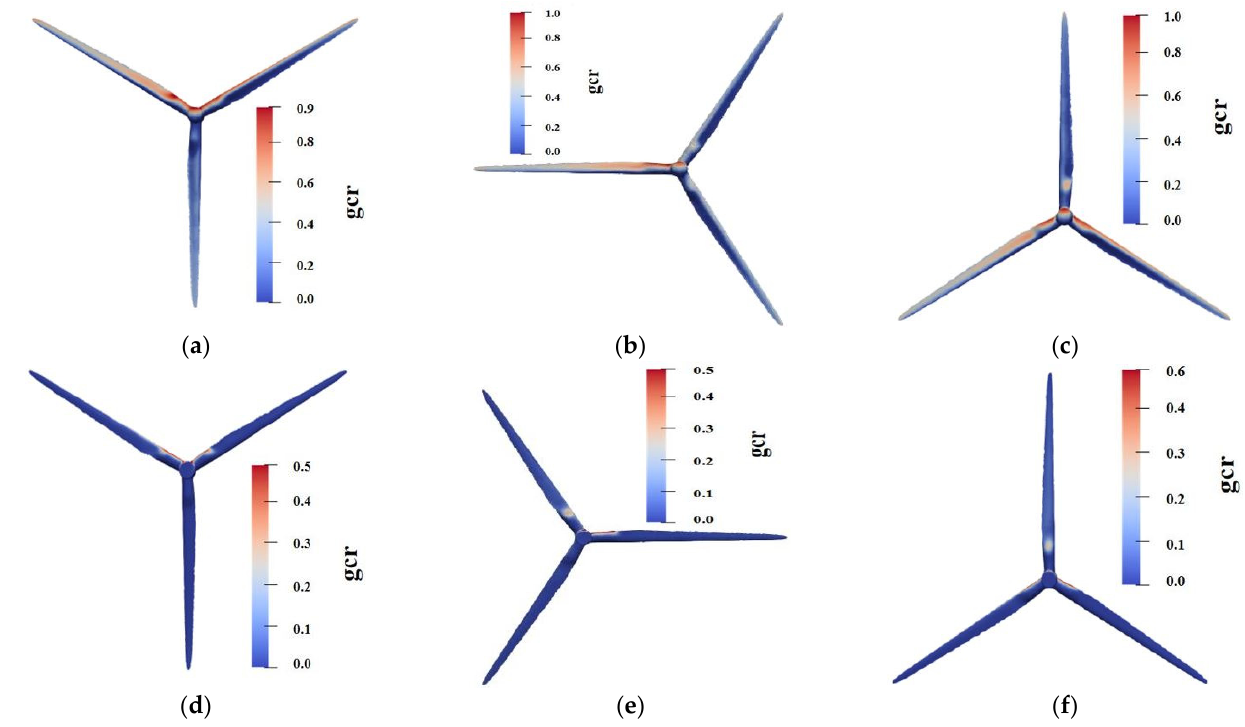
Figure 12. Rainwater distribution when V = 3 m/s; ( a ) front face of blade at 0°; ( b ) front face of blade at 30°; ( c ) front face of blade at6 0°; ( d ) back face of blade at 0°; ( e ) back face of blade at 30° ( f ) back face of blade at 60°.